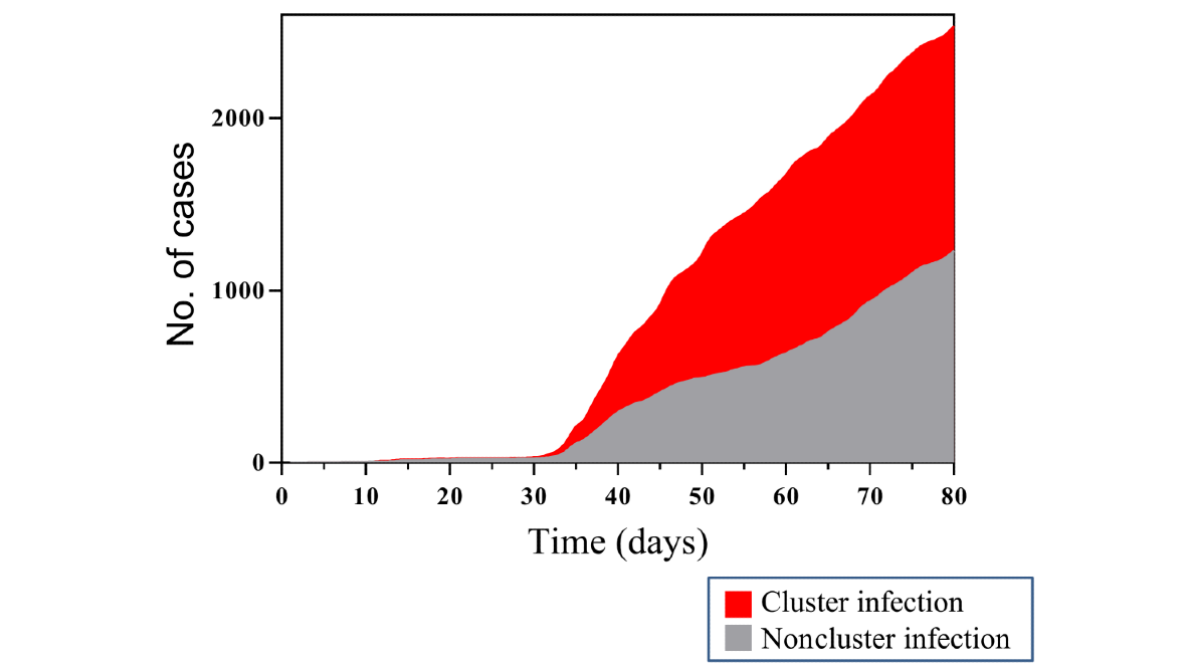
Figure 2. Number of infections based on infection type (cluster and contact cases vs noncluster cases) in South Korea from January 19, 2020, to